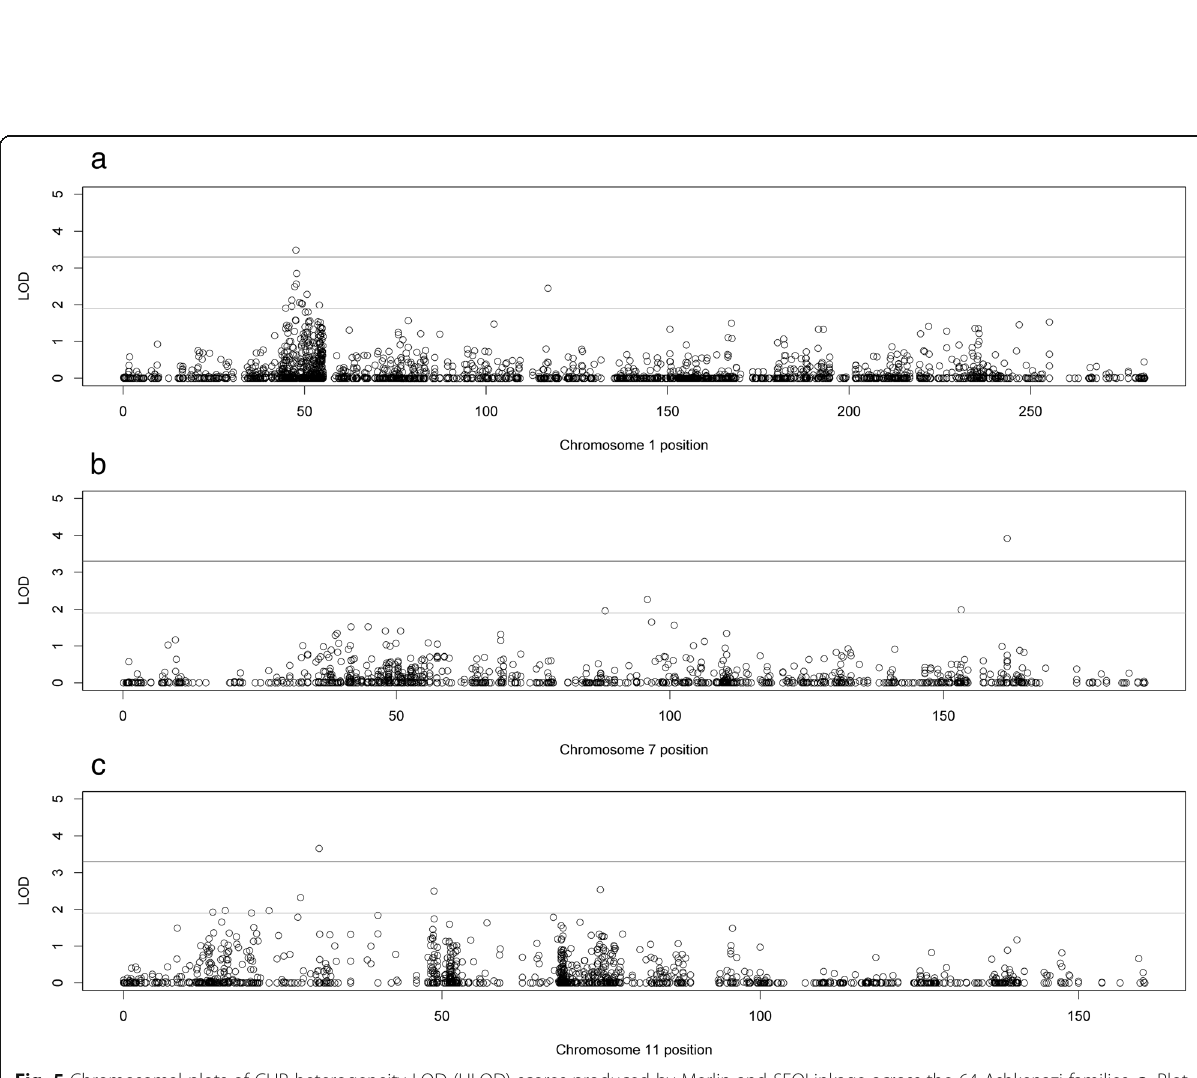
Fig. 5 Chromosomal plots of CHP heterogeneity LOD (HLOD) scores produced by Merlin and SEQLinkage across the 64 Ashkenazi families. a . Plot of chromosome 1 in cM. b . Plot of chromosome 7 in cM. c . Plot of chromosome 8 in cM. In all plots, the lines at 1.9 and 3.3 represent the respective suggestive and significant thresholds recommended by Lander and